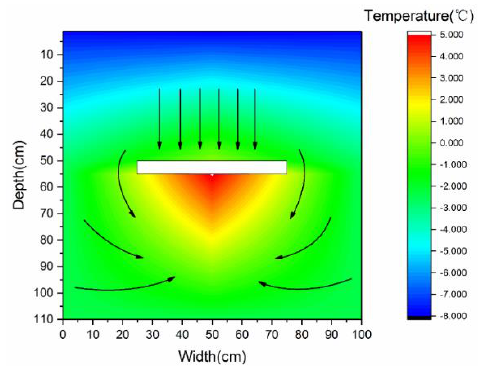
Figure 6. Schematic diagram of negative temperature flow.